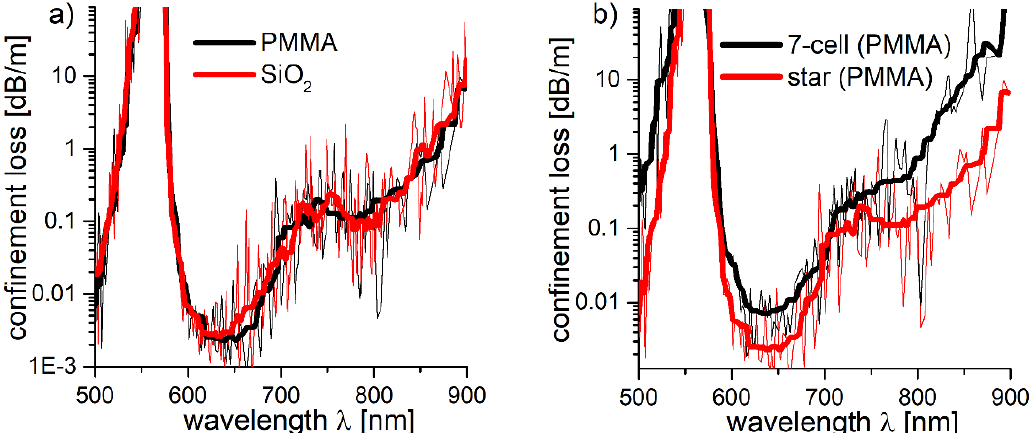
Figure 11. ( a ) Comparison of the confinement loss ( CL ) spectrum of the star structure, based on polymethylmethacrylate (PMMA, black line) and SiO 2 (silica glass, red line). The spectra are almost identical. ( b ) The CL spectrum for the PMMA-based 7-cell and star structures (black and red line, respectively). As in the case of their SiO 2 -based counterparts, a significant reduction of CL in the 750–800 nm spectral region is observed for the star structure.